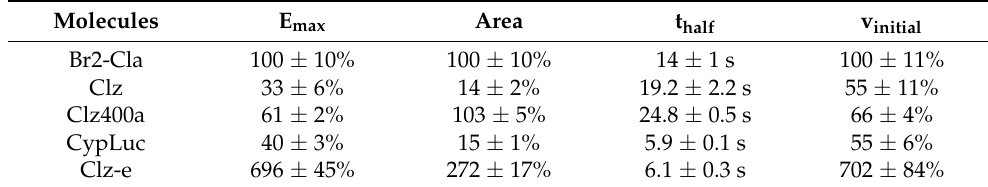
Table 1. Light-emission intensity maximum (E max , in RLU), calculated area of total light-emission (area, in RLU), light-emission half-life (t half , in s) and initial velocities (v initial , in RLU s − 1 ), for CL reactions of Br2-Cla, Clz, Clz400a, CypLuc and Clz-e in DMSO. Measurements were performed in solutions with a final concentration of 0.73 µ M. Values are presented in percentage (%), with the results for Br2-Cla as reference.